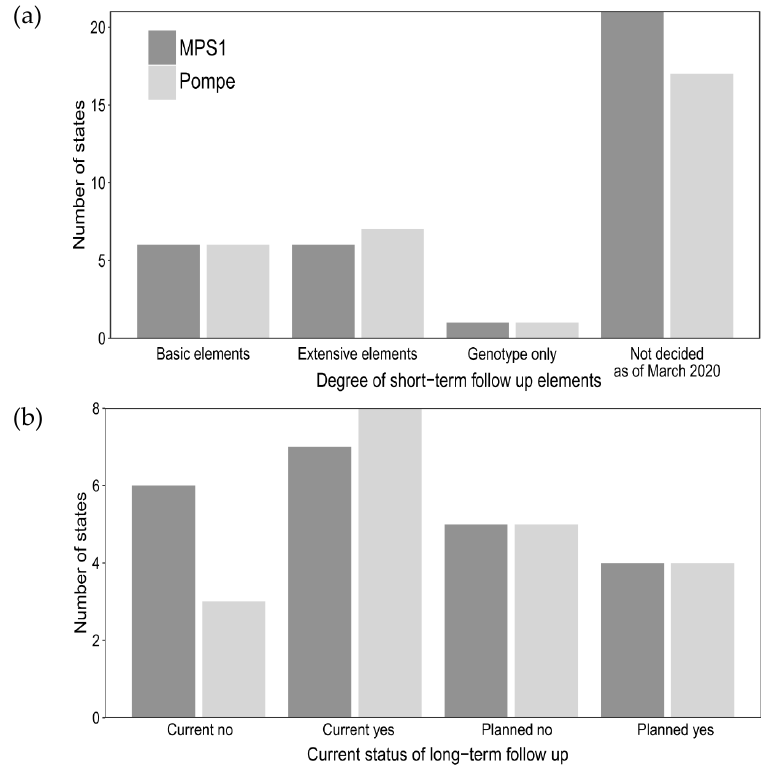
Figure 4. Current and planned efforts for short- and long-term follow-up for MPSI (dark gray) and Pompe disease (light gray). ( a ) Degree of short-term data elements collected (see methods section for explanation of basic and extensive elements); ( b ) Status of long-term follow-up for current and planned screening.